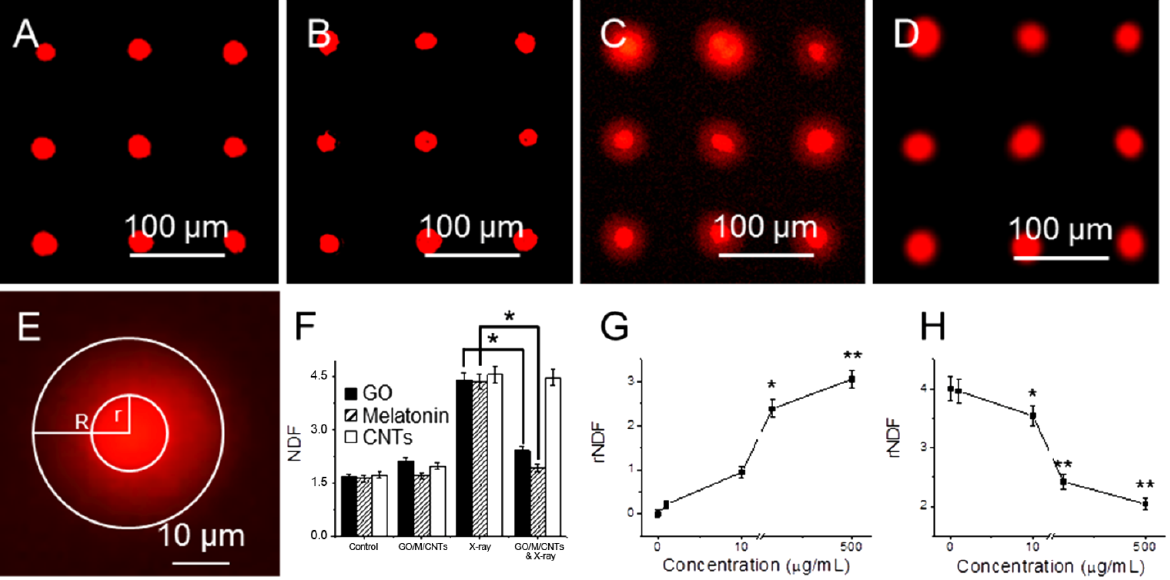
Figure 2. Genotoxicity of cells treated with GO and X-ray irradiation with halo assay. Fluorescent images of arrayed cells ( A ); cells treated with 10 µg/mL GO ( B ); cells exposed to 1.25 Gy X-ray ( C ); and cells treated with GO and then exposed to 1.25 Gy X-ray ( D ); an enlarged image shows that halo and nucleus ( E ); the NDF values of cells after different treatment ( F ); the rNDF values of cells treated with different concentration of GO without ( G ) and with 1.25 Gy X-ray radiations ( H ). “ * ” ( p < 0.05) and “ ** ” ( p < 0.01) represent significant difference and extra significant difference,